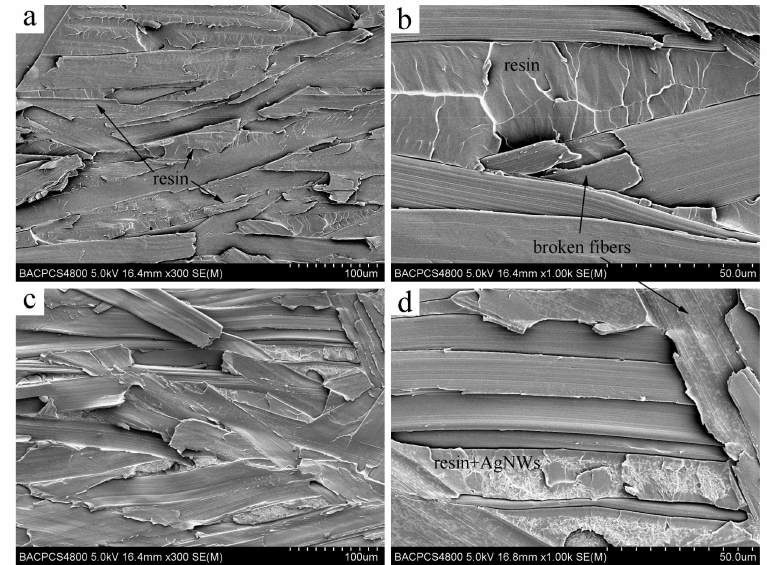
Figure 8. SEM images of Mode I fracture surfaces of ( a , b ) plain paper interleaved composite and ( c , d ) conductive paper interleaved